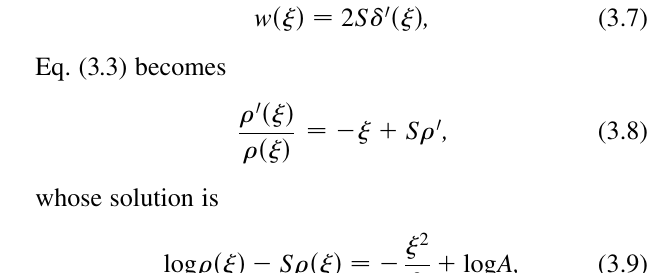
versus b < 0 for T (cid:6) 200 , (cid:15) ij